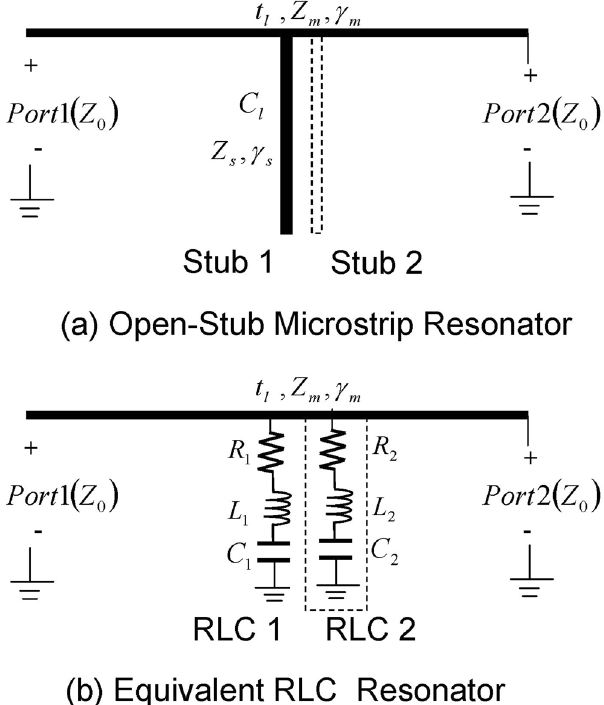
Figure 1. ( a ) The schematic diagram of the proposed multiple open-circuited stubs structure which consist of a microstrip transmission line of length ‘ t l ’, characteristic impedance “ Z om ”, and propagation constant γ m loaded by open circuit stub of impedance Z s , length C l , and a propagation constant γ s ( b ) The equivalent circuit of the open stub structure consists of series RLC